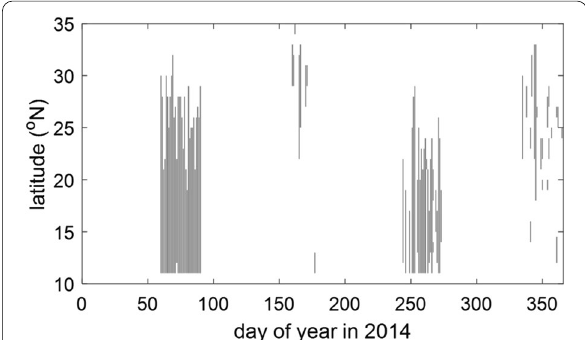
Fig. 9 Latitude ranges of the irregularities in 2014 basd on